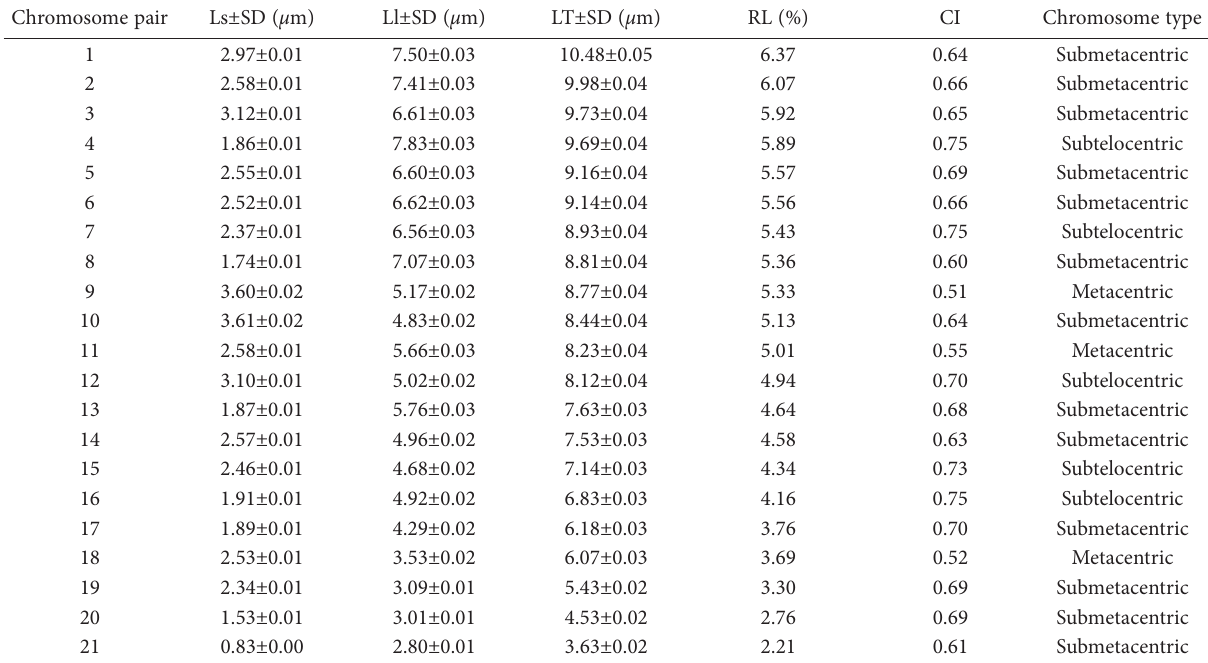
Table 3. Mean length of short arm chromosome (Ls), long arm chromosome (Ll), total arm chromosome (LT), relative length (RL), cen- tromeric index (CI) and standard deviation (SD) of RL, CI from 20 metaphases of Ag. simplex (2 n =42). Chromosome